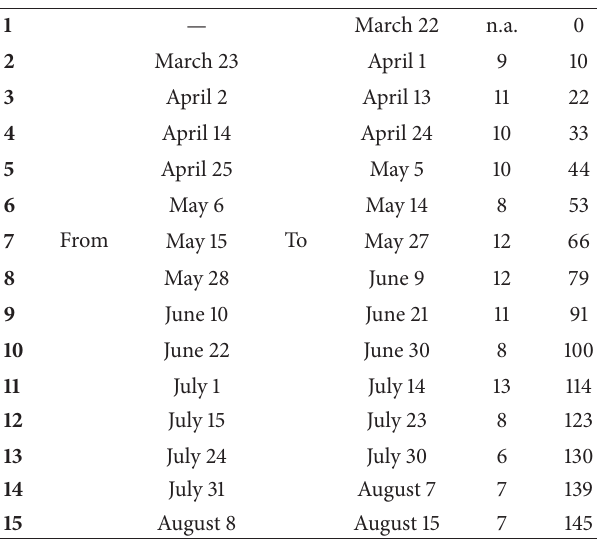
Table 1: Periods considered for time-to-time evaluation of the EVD outbreak during 2014 in West Africa. First column represents the period. The third column represents the data of the report released by WHO or CDC. In the fourth column the duration of each period is represented in days. The last column shows the days